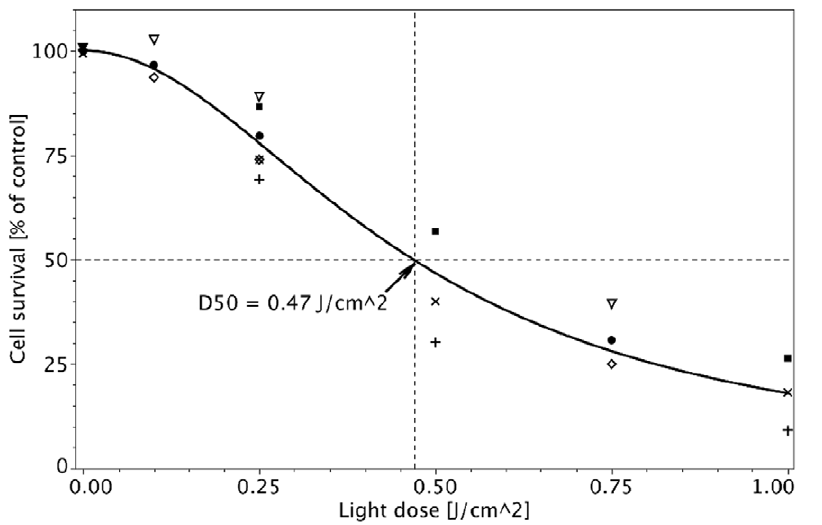
N , % , # , e , and g are the mean observed values of six